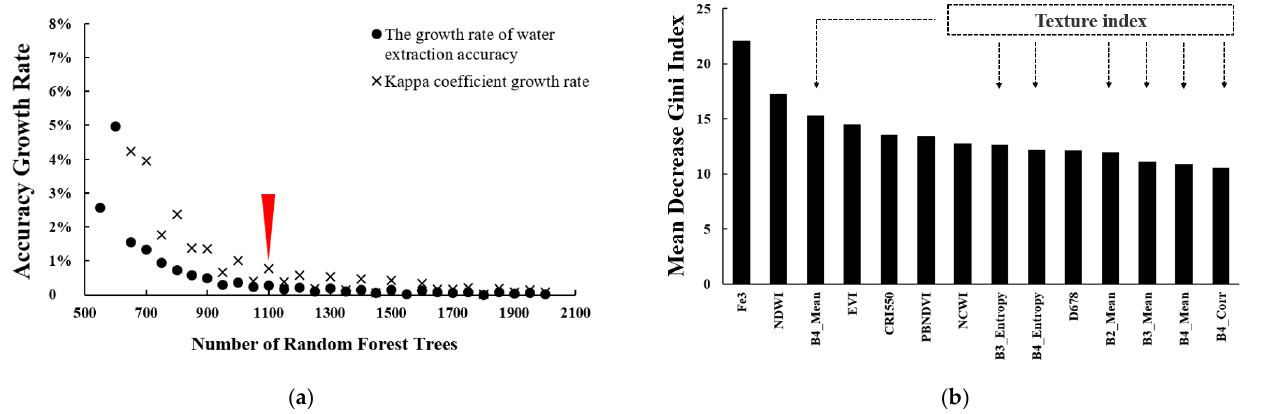
Figure 7. Result of the RF algorithm pre-experiment. ( a ) RF parameter optimization. ( b ) The final selection of classification index and importance ranking .